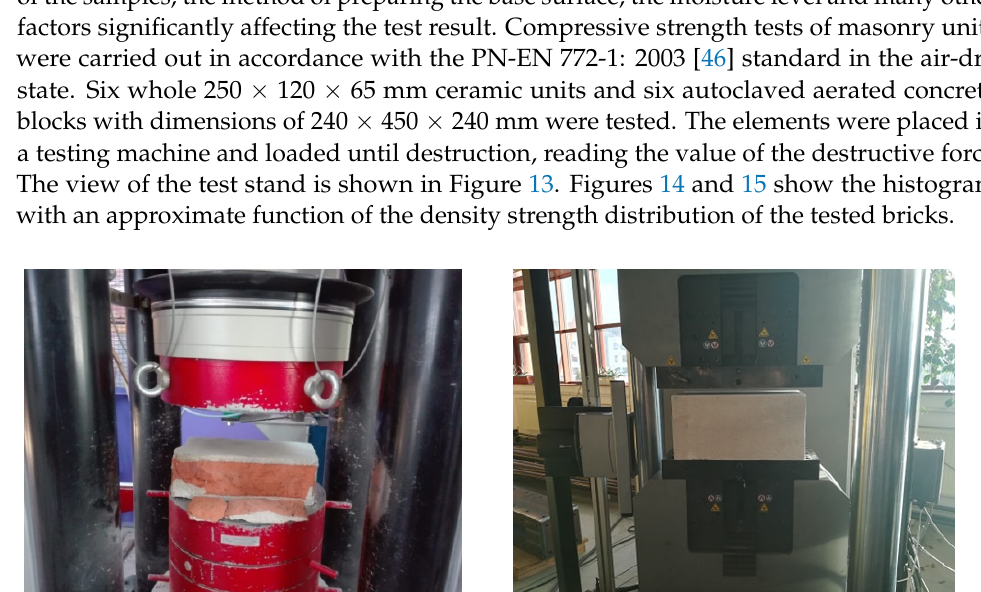
concrete blocks. concrete